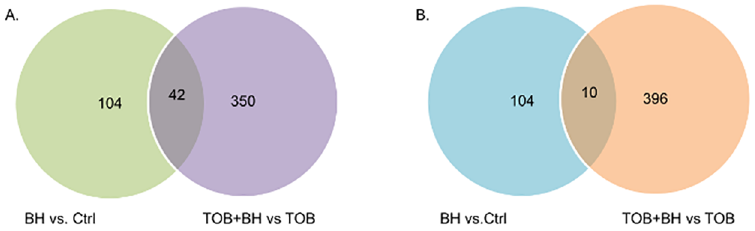
Fig 2. Differentially expressed genes in B . cenocepacia J2315 biofilms exposed to different treatments. A. Downregulated genes. B. Upregulated genes.